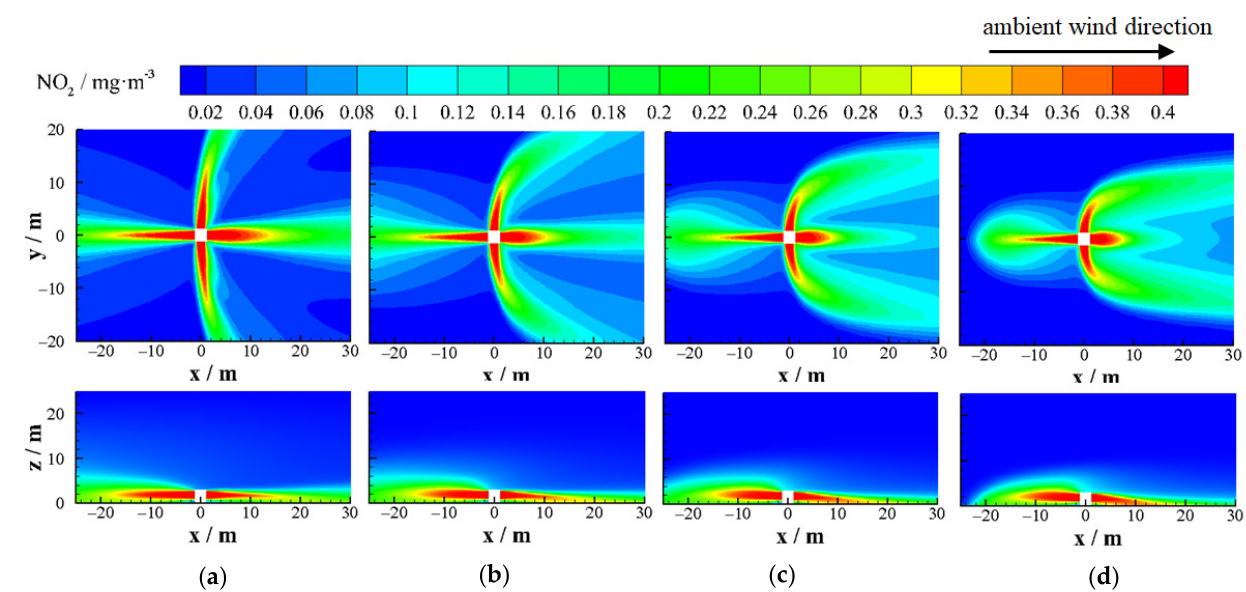
Figure 15. NO 2 distributions of the horizontal outlet when V 0 = 6 m/s without considering the ambient wind: ( a ) U = 1 m/s; ( b ) U = 2 m/s; ( c ) U = 3 m/s; ( d ) U = 4 m/s.